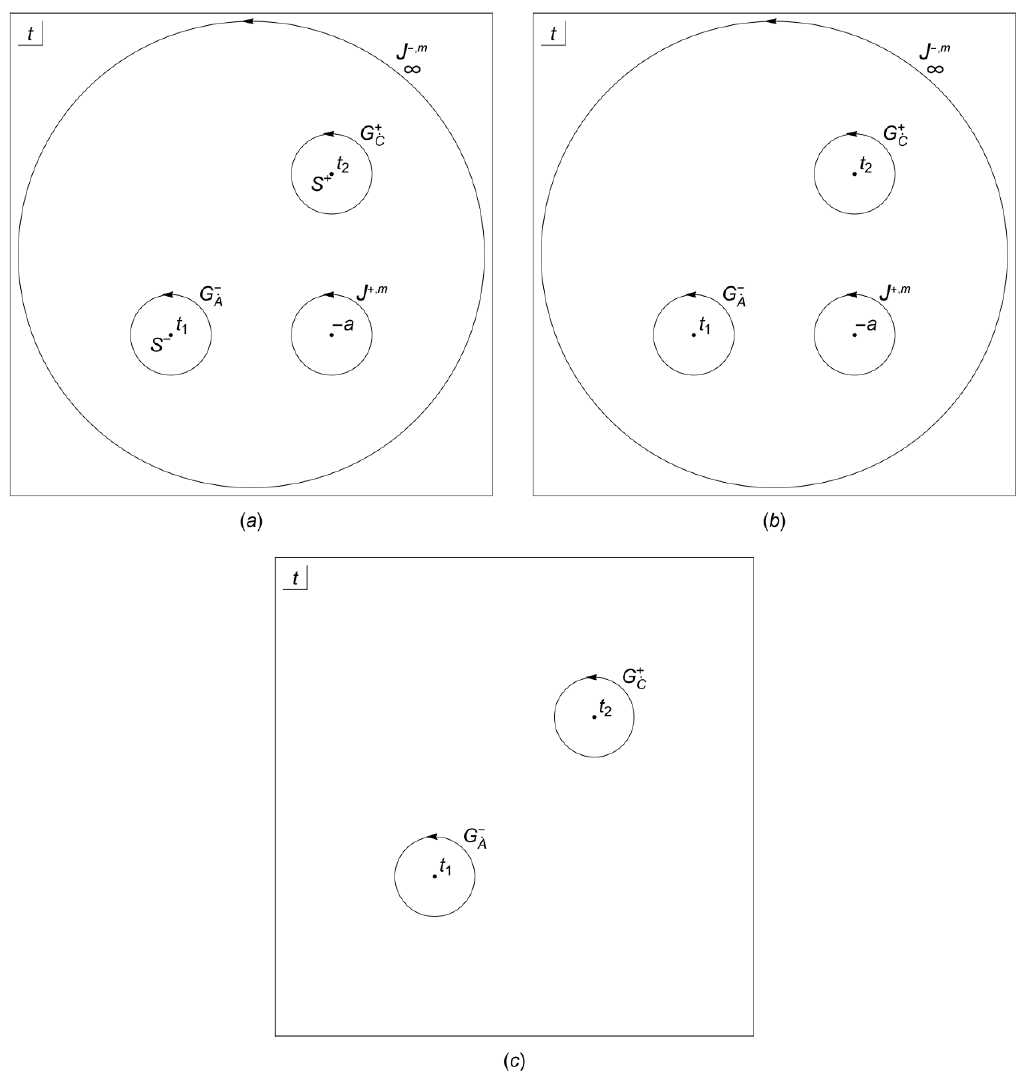
contour circling t 1 , the _ A